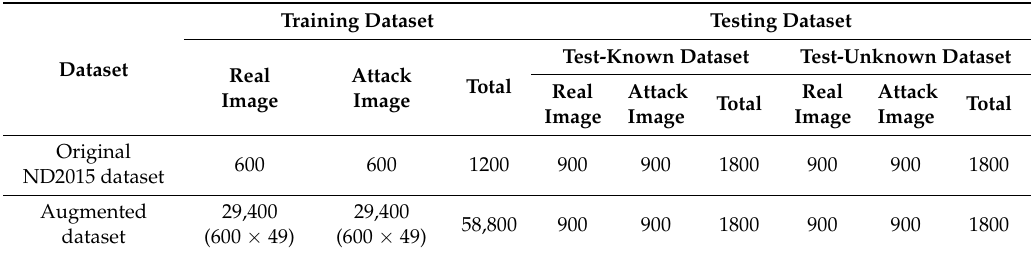
Table 6. Description of training and testing data used with ND2015